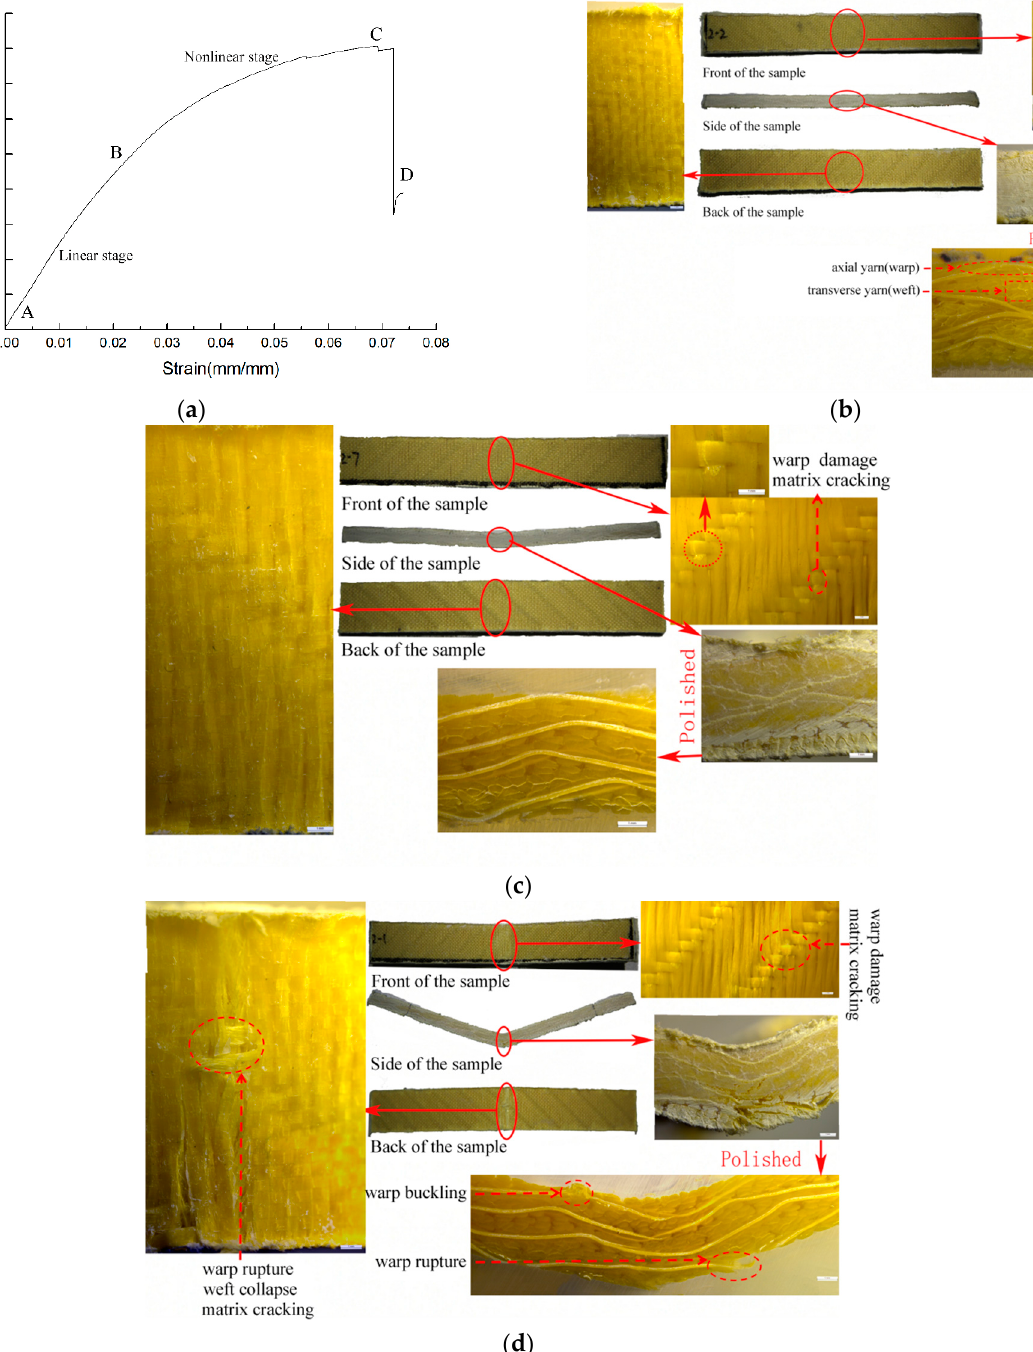
Figure 4. The bending response of 3DDAI Kevlar/EP armor material when loaded along the warp direction. ( a ) The bending stress-strain curve. ( b ) The topography of the material at point B. ( c ) The topography of the material at point C. ( d ) The topography of the material at point D.